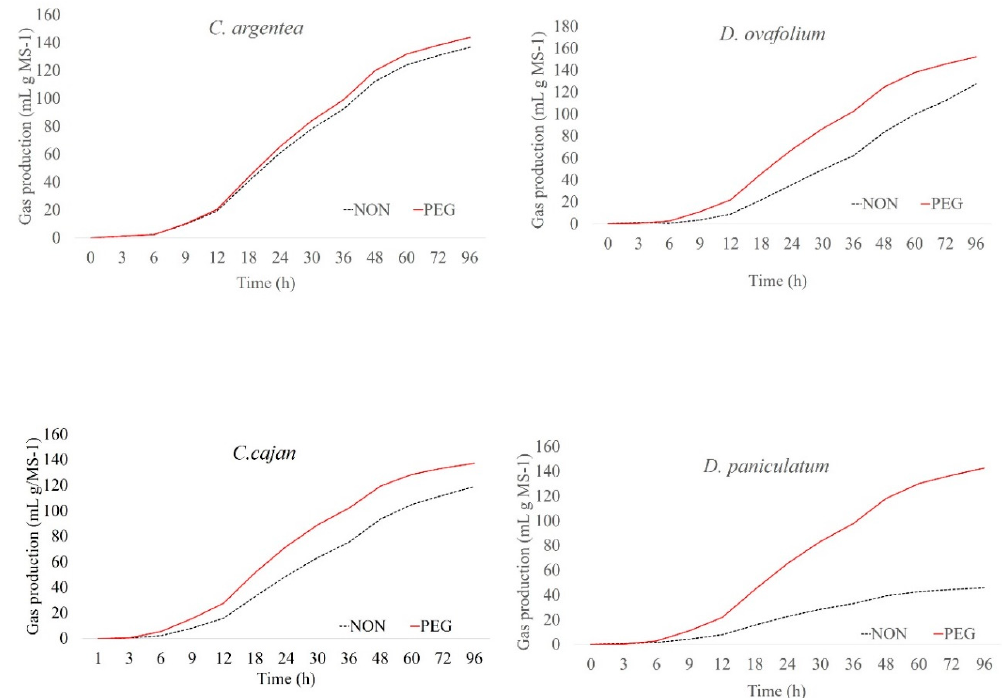
Figure 1. Cumulative gas production curves of Cratylia argentea , Cajanus cajan , Desmodium ovalifolium , and Desmodium paniculatum incubated at the end of 96 h.